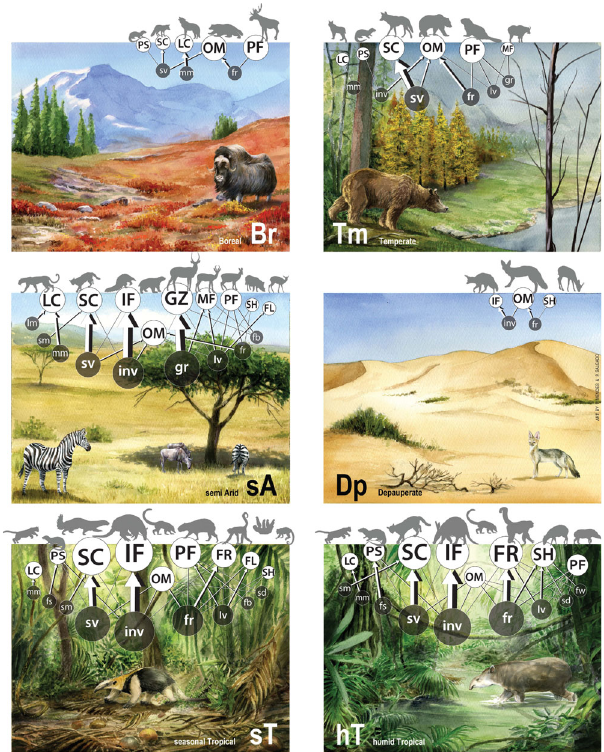
Fig. 1 Six types of mammal trophic structures around the world: boreal, temperate, semi-arid, seasonal tropical, humid tropical, and depauperate. For convenience, trophic structures are represented as bipartite networks depicting energy fl ows between trophic guilds and their main resources.